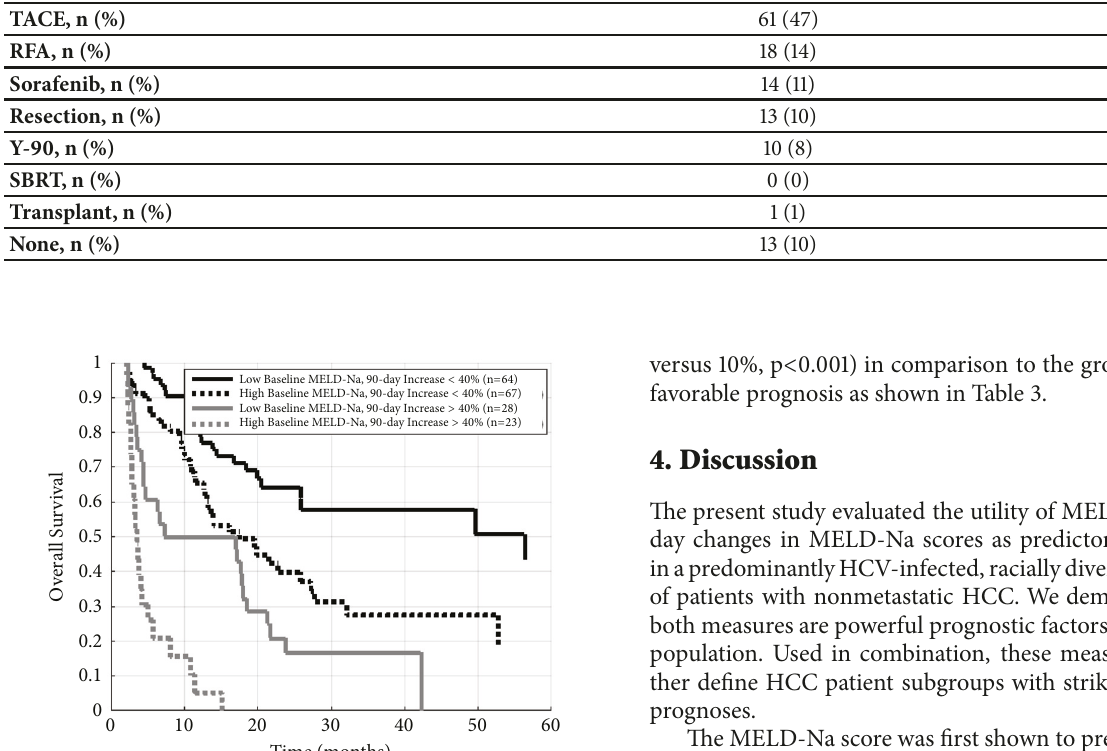
Figure 3: Kaplan-Meier overall survival curves after grouping patients by both baseline MELD-Na and MELD-Na increase. “Low” and “High” baseline MELD-Na groups defined as ≤ 9.7 or > 9.7,